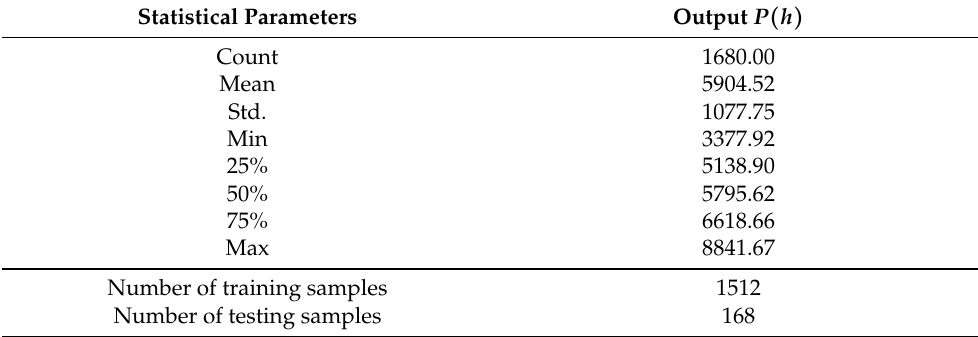
Figure 3. Histogram plot for output feature P ( h ) . Table 3. Load data